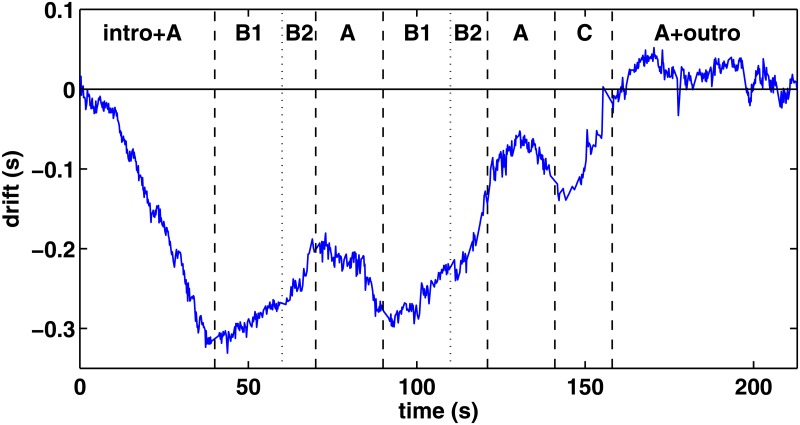
Drift of the sixteenth note pulse, i.e., the deviation from an imaginary metronome during the song.A, B1, B2, and C mark different parts of the song (see text).